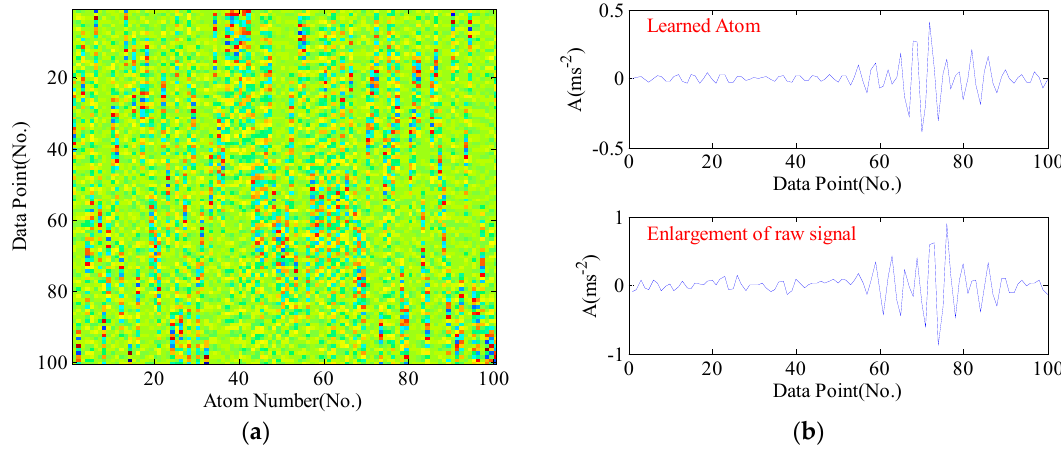
Figure 6. The learned dictionary from the sample signal of inner race fault: ( a ) the learned dictionary matrix; ( b ) the learned atom and enlargement of the raw signal.